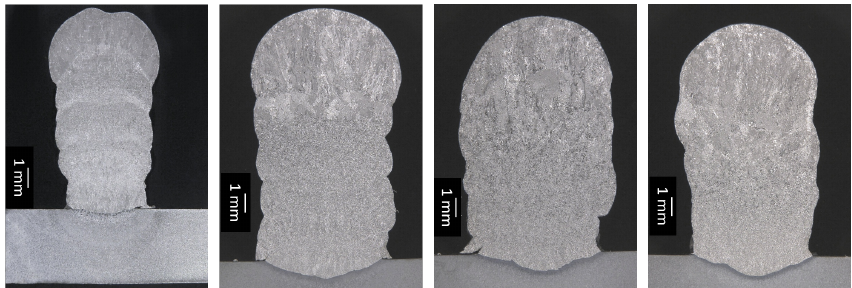
Figure 12. Macrographic images to assess consistency of multilayer deposition.